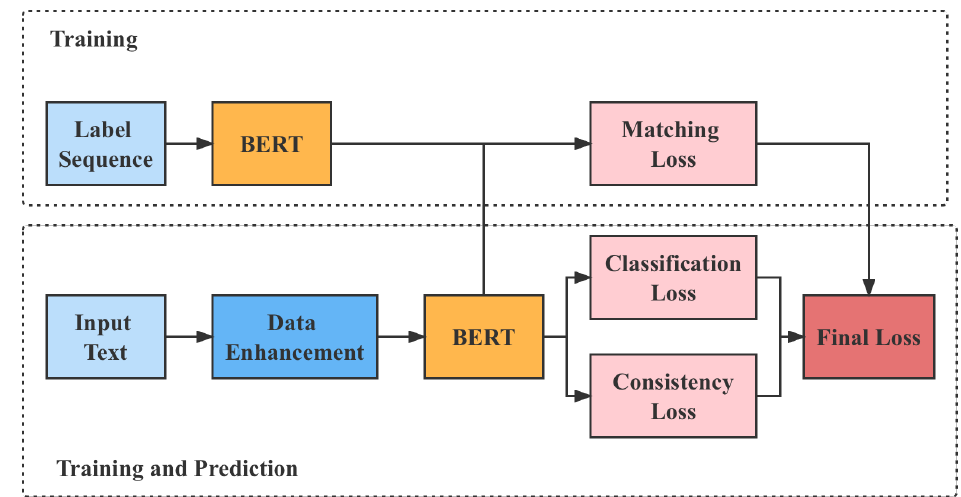
Figure 9. Structure of information improved by contrastive